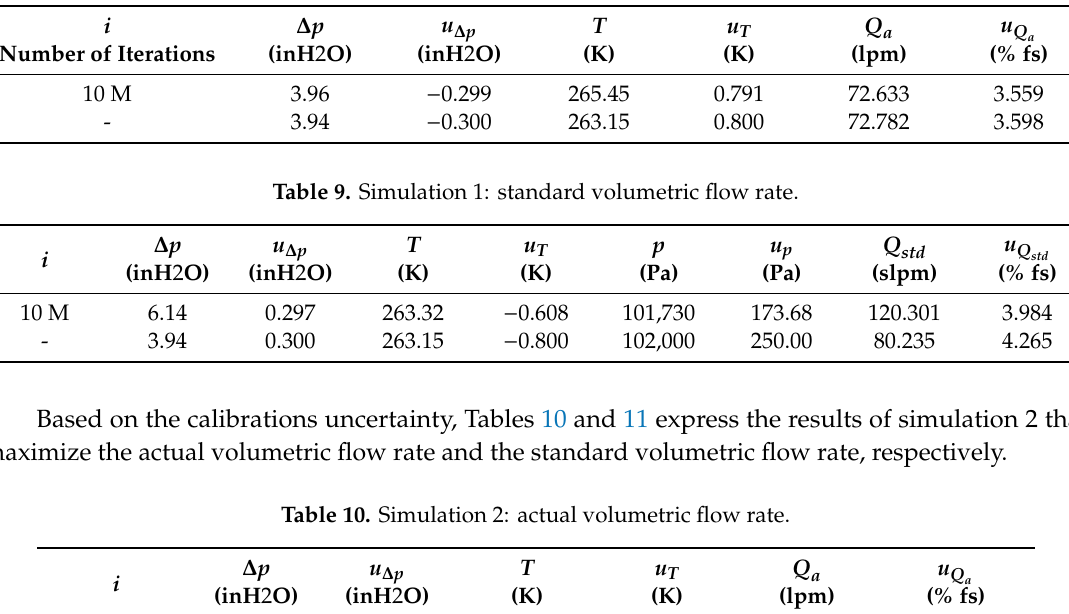
Table 8. Simulation 1: actual volumetric flow rate.